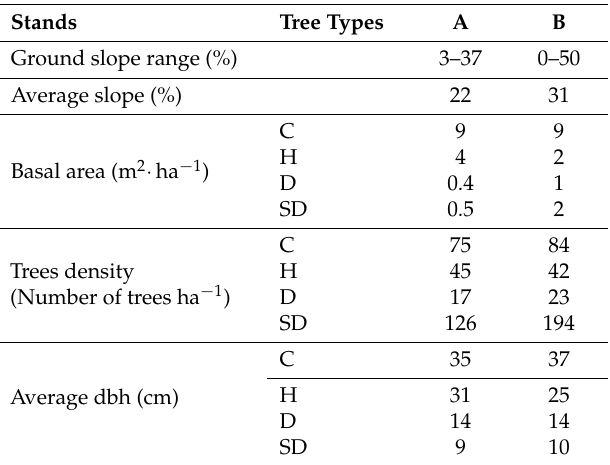
Table 2. Summary of stand conditions (A and B) and inventory for the localized redwood allometric model study on a per hectare basis.